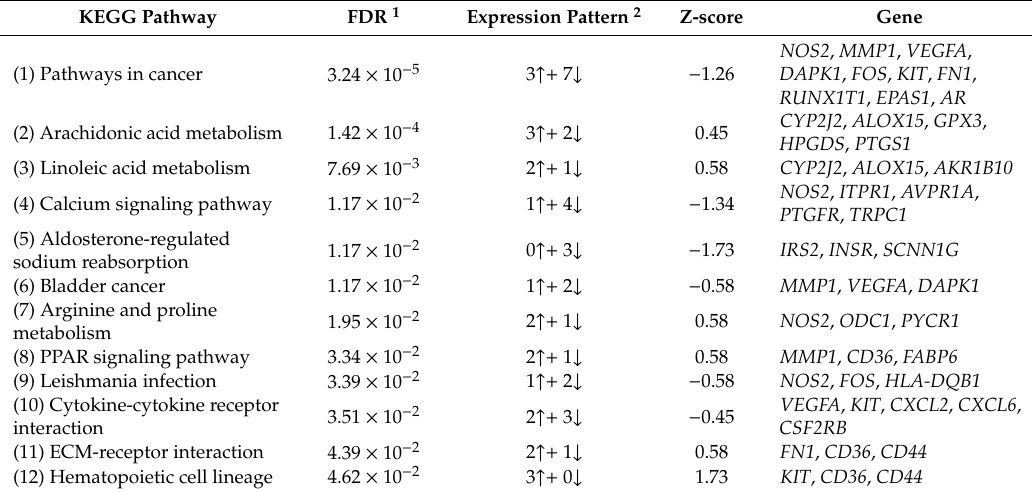
Table 4. Enriched KEGG (Kyoto Encyclopedia of Genes and Genomes) pathways for DEGs using Molecular Signatures Database from GSEA (Gene Set Enrichment Analysis) online